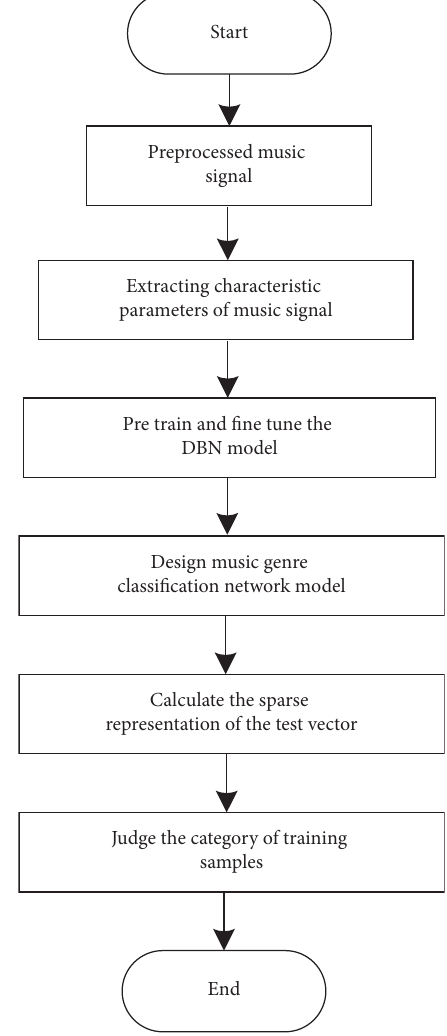
Figure 3: Flow chart of automatic classification of music genres based on deep belief network and sparse